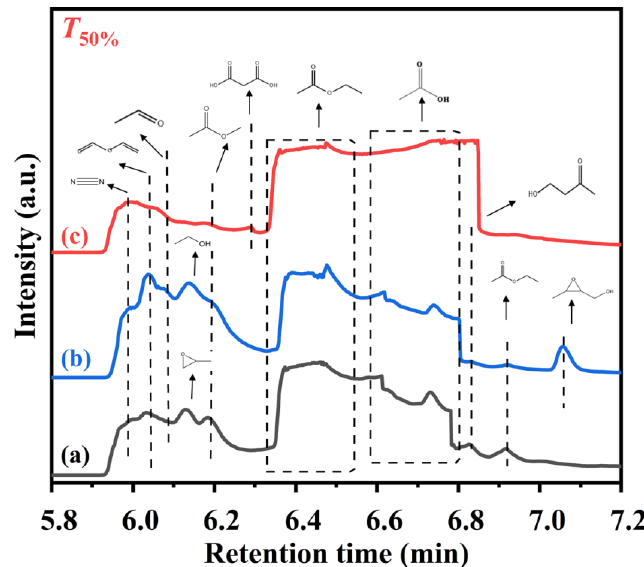
Figure 9. GC/MS chromatograms of the gaseous organic products of ethyl acetate oxidation at T 50% over ( a ) TiO 2 , ( b ) 0.33Pd/TiO 2 , and ( c ) 0.34AuPd 2.09 /TiO 2